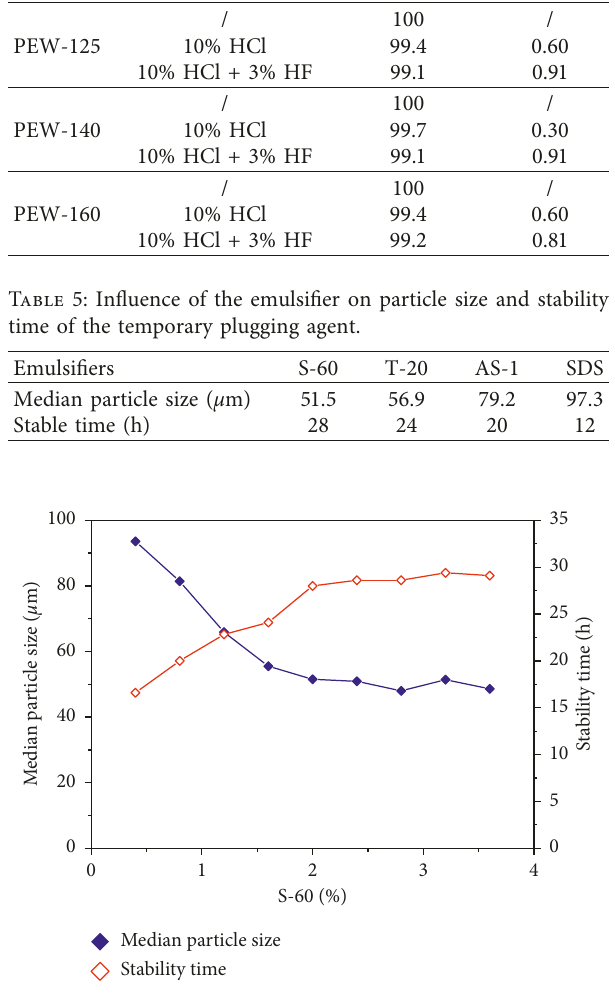
Figure 2: Influence of emulsifier S-60 dosage on particle size and stability time of the temporary plugging